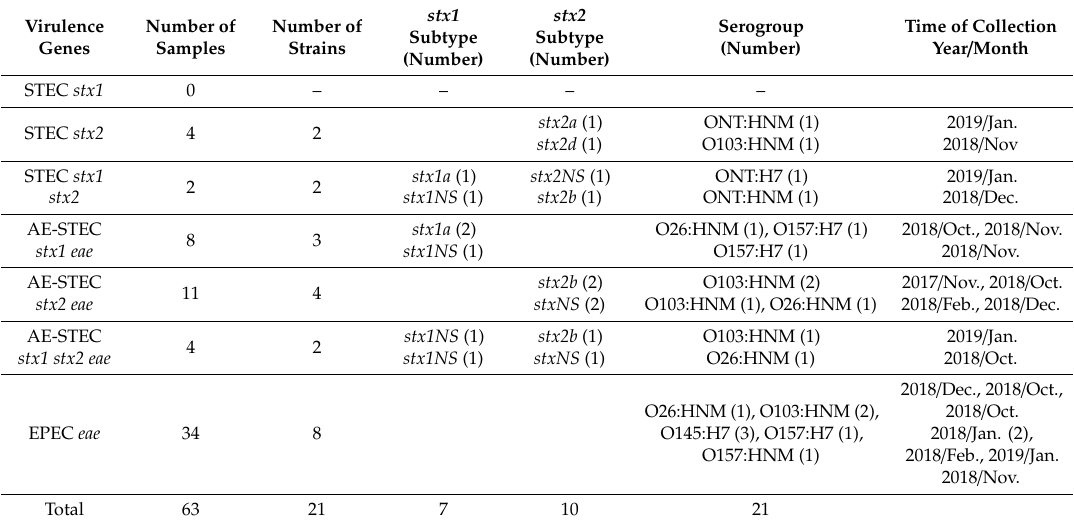
Table 1. Pathotypes and O serogroups of Shiga toxin-producing Escherichia coli / attaching and e ff acing (STEC / AE)-STEC and enteropathogenic Escherichia coli (EPEC) isolated from fallow deer ( Dama dama